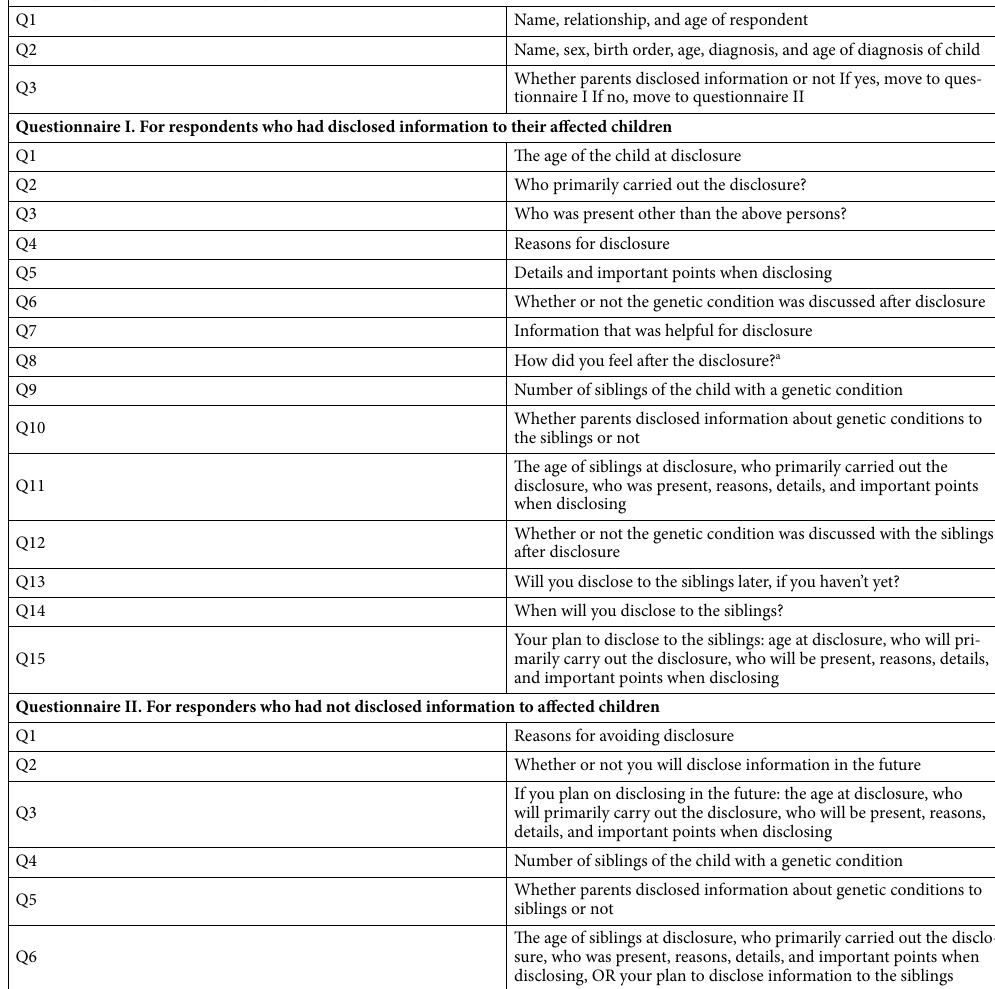
Table 1. Questionnaires. a Respondents were asked to indicate the degree of their feelings by choosing any number on a scale of